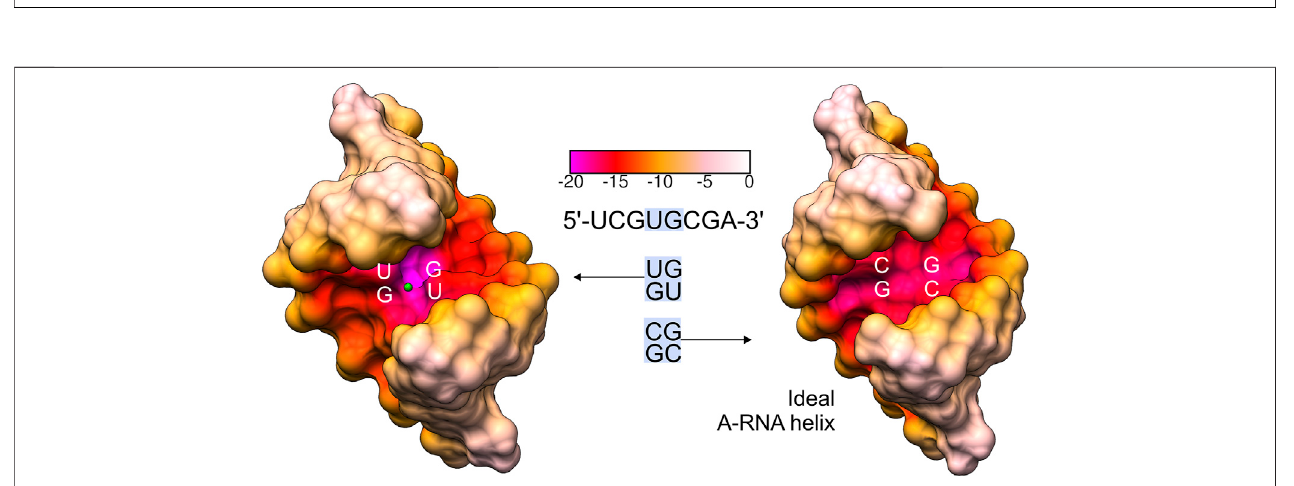
FIGURE4| Thecation bindingsite iscreated byfunctionalgroupsofthe5 ′ UG/3 ′ GUwobble tandem [O6carbonylgroup ofG5(chain A)and O4carbonylgroupof U4 in both chains] poised into the major groove. Ba 2+ and water molecules are marked as green and red balls , respectively.